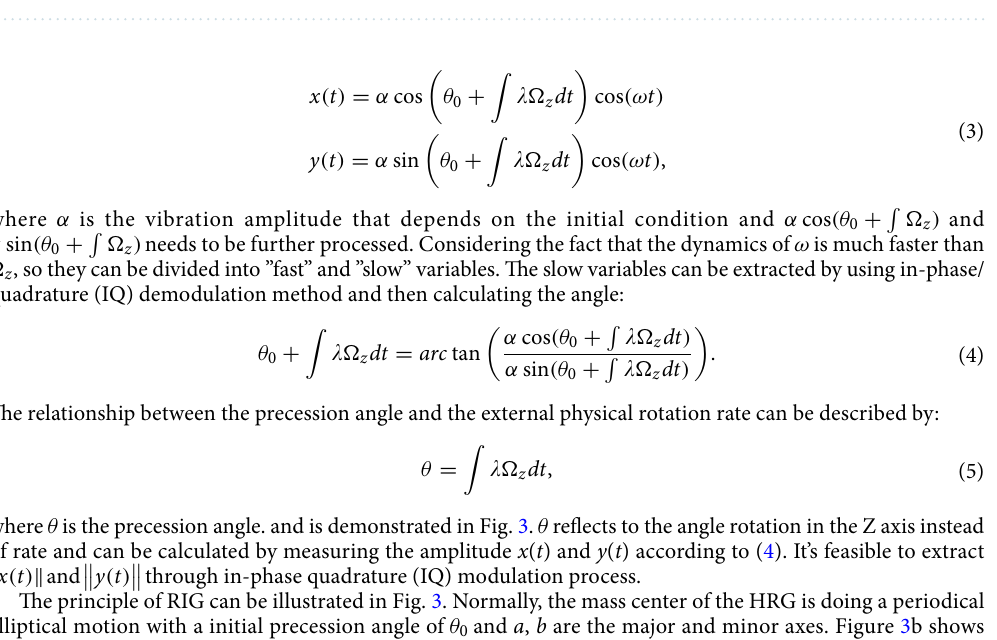
Figure 3. Mass center orbit of the HRG